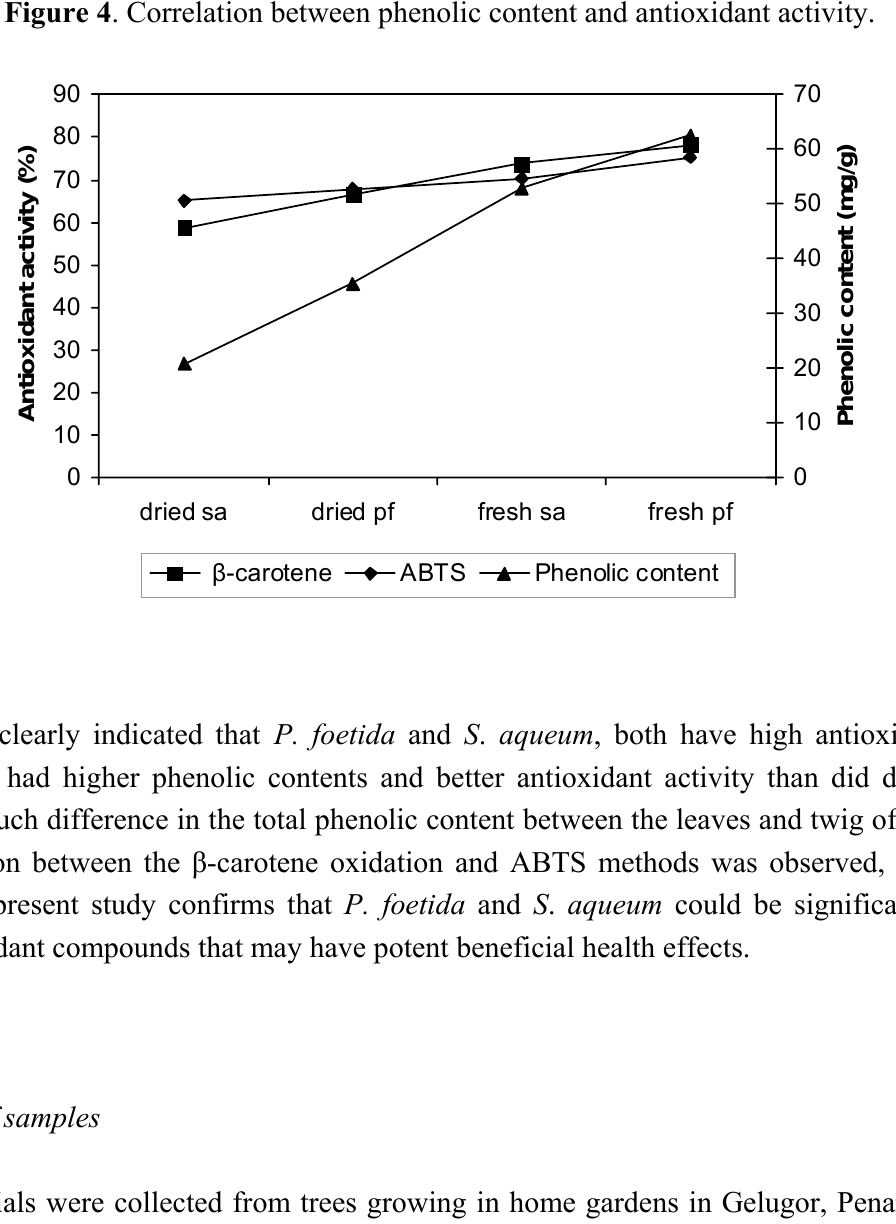
Figure 4 . Correlation between phenolic content and antioxidant